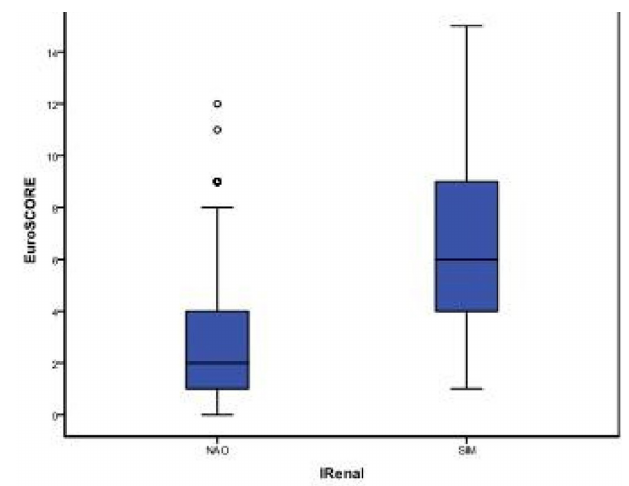
Fig. 2 – Comparison of EuroSCORE in patients with and without RTI